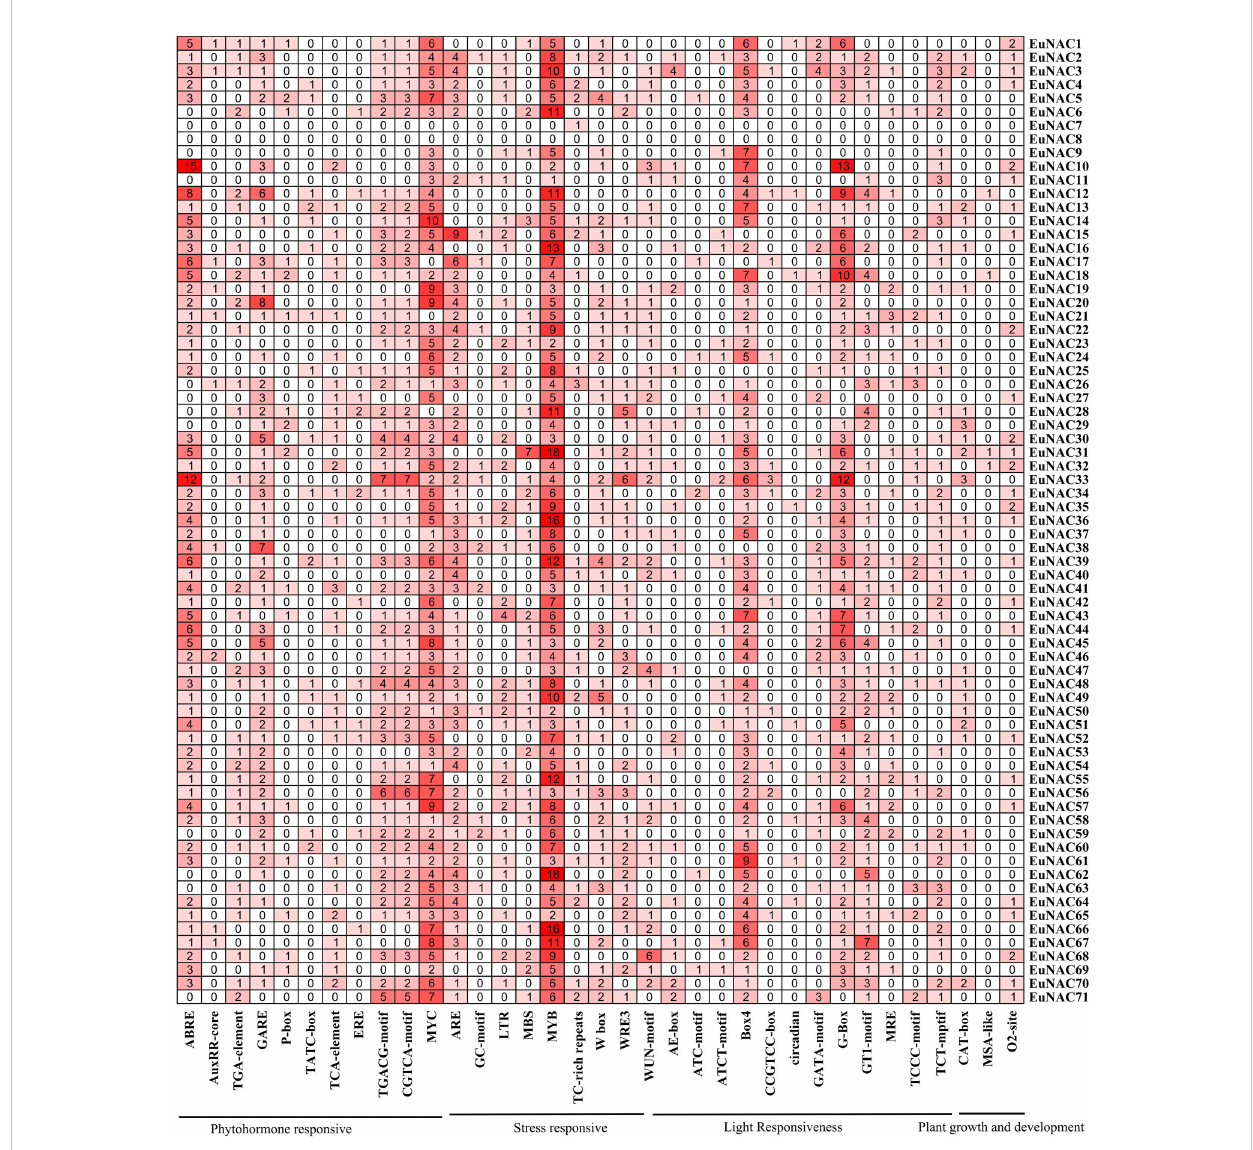
FIGURE 7 Cis-acting elements in promoter region of EuNAC genes in E. ulmoides . The number and the shade of red indicate the number of cis-acting